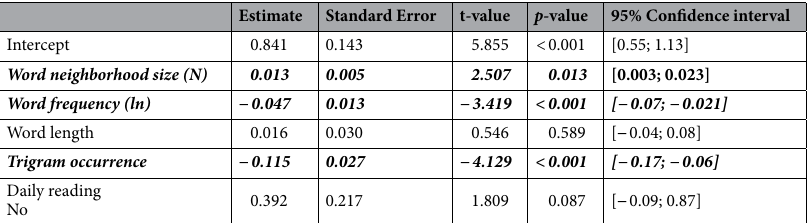
Table 4. Fixed-effects estimates from the simple LME model (analysis 2). The dependent variable is log- transformed target word total reading time. The intercept estimate represents the log-transformed reading time when all factors included in the model are at their reference level (categorical variable) or at 0 (continuous variables). Reference level for the binary factor “Daily reading” is ‘yes’. Factors showing a significant effect on reading time are in bold font and highlighted in italic.